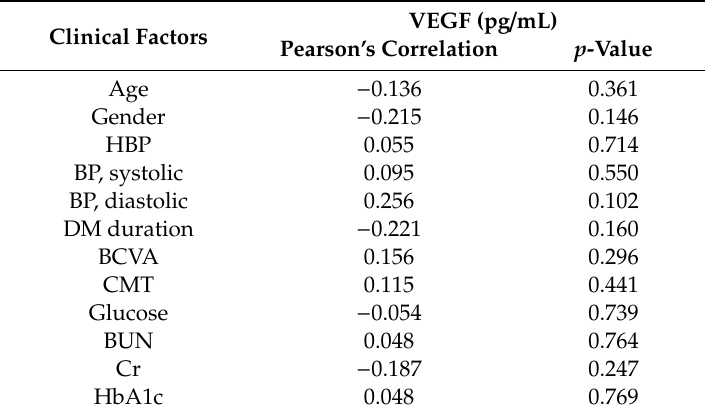
Table 5. Correlation between clinical factors and VEGF level.